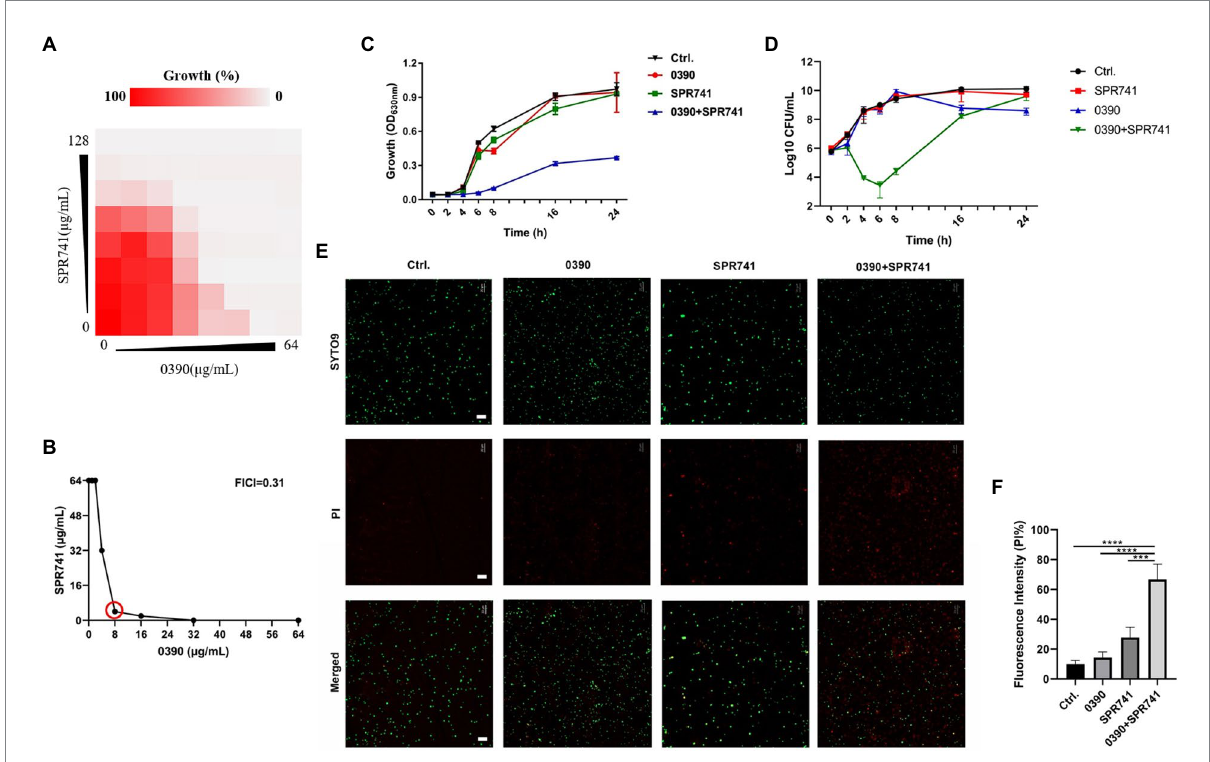
FIGURE 3 Combinational bacteriostatic effects between 0390 and SPR741 against Escherichia coli ATCC 25922. (A) Synergistic antimicrobial effects between 0390 and SPR741 by using drug combination assays. (B) Calculation of the fractional inhibitory concentration index (FICI). The red circle indicates the optimal FICI. (C) The time-growth inhibition curves and (D) time-killing curves of E. coli in the presence of 0390 (1/4 × MIC) and SPR741 (1/8 × MIC) alone or in combination. The experiment was repeated three times. (E) Viable cells visualization detected by SYTO 9 and PI staining, with treatment of 0390 (1/4 × MIC) and SPR741 (1/8 × MIC) alone or in combination. Green indicates live cells and red indicates dead cells. Scale bar: 20